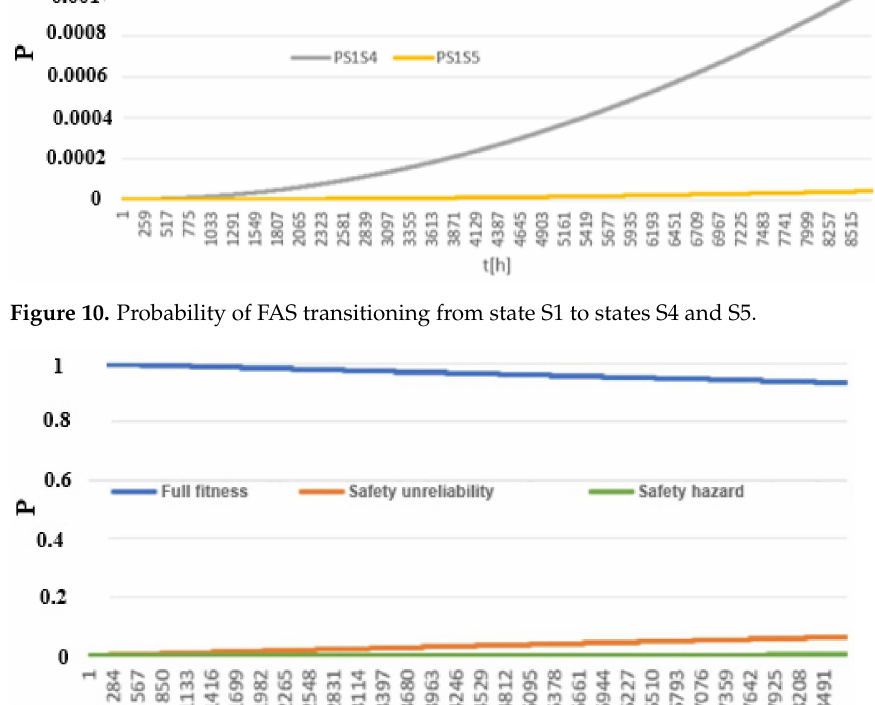
for FAS, according to Expression